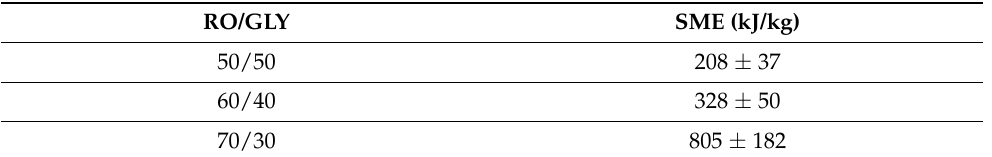
Table 1. Specific Mechanical Energy (SME) involved in the mixing of different RO/GLY systems (t mix : 5 min).